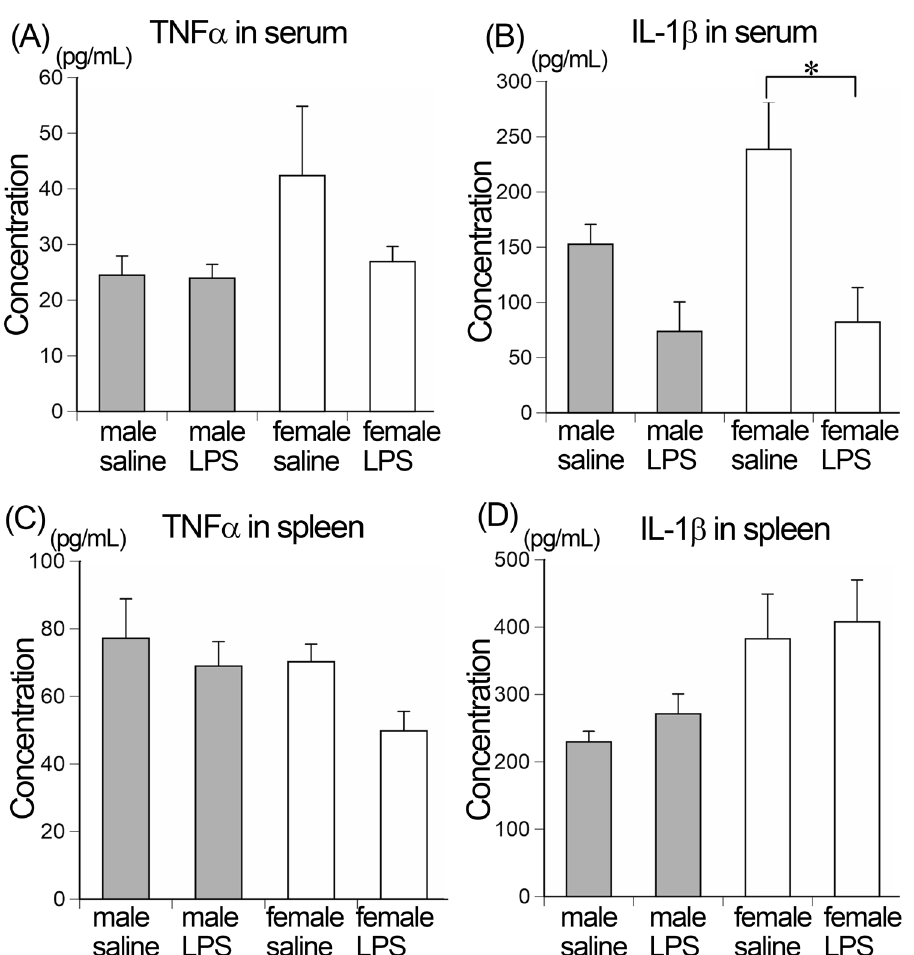
Figure 5. ELISA analysis. The concentrations of TNFα and IL-1β in the serum ( A and B , respectively) and spleen extraction ( C and D , respectively) of male saline, male LPS, female saline and female LPS group mice. There was no significant increase in LPS-treated male or female mice. n = 5 for each